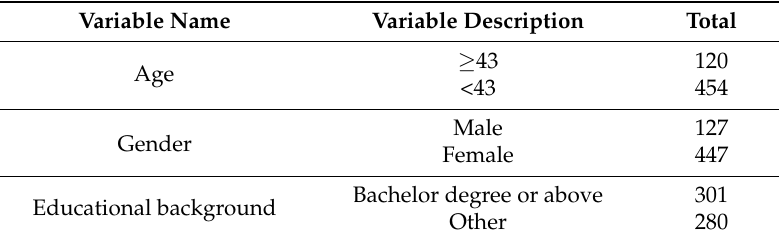
Table 2. Research sample description table.